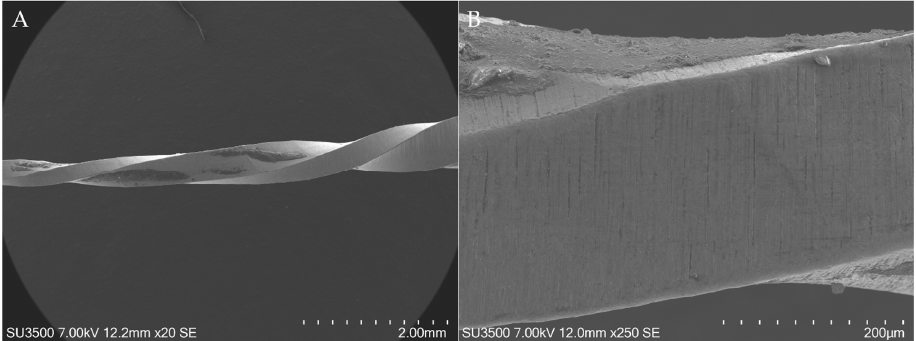
Figure 5. SEM micrographs showing the distortion of spirals of EOF instrument. ( A ) Stretching of the spiral at ×20 magnification. ( B ) Particular of image A acquired at higher magnification (×250), in which an alternation of the spiral can be noted.